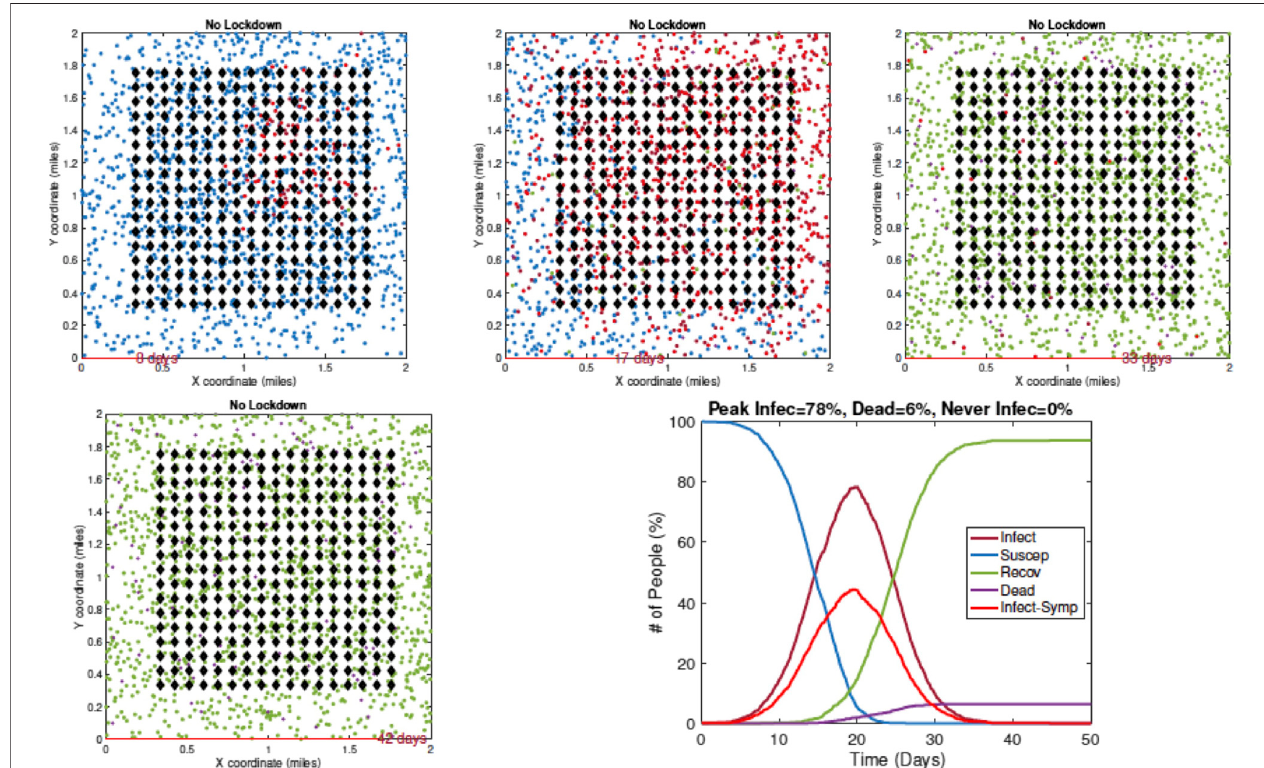
FIGURE 7 | Example 1: model outputs at different times under no restrictive measures. Blue dots are susceptible agents, red dots are infected agents, green dots are recovered agents, and purple circles denote fatalities. The pandemic curves in the bottom right exhibit typical behavior of the RAW-ALPS model at the population